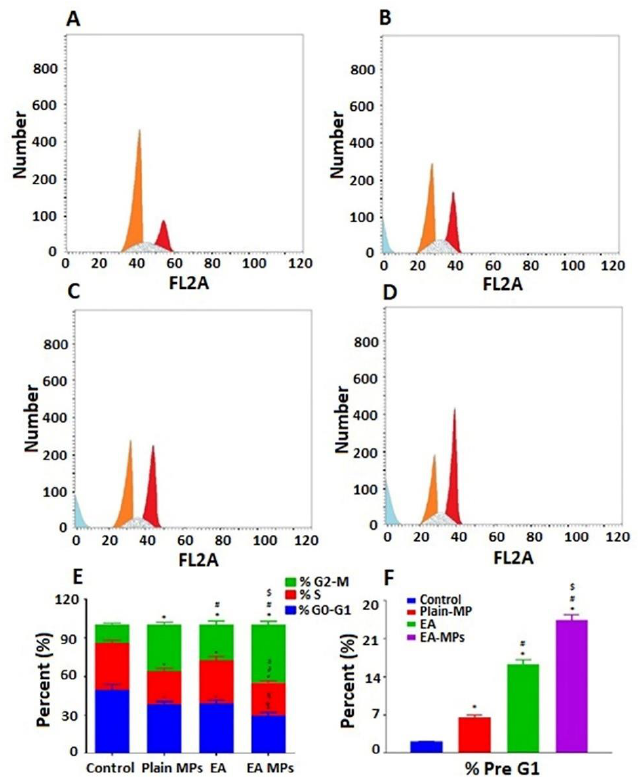
Figure 4. Impact of the EA MPs on the cell-cycle phases. ( A ) Control, ( B ) plain MPs, ( C ) raw EA, ( D ) EA MPs, ( E ) graphical presentation of each phase, and ( F ) graphical presentation of pre-G1 phase. * Significantly different from corresponding control at p < 0.05; # significantly different from plain MP at p < 0.05; $ significantly different from EA at p < 0.05.